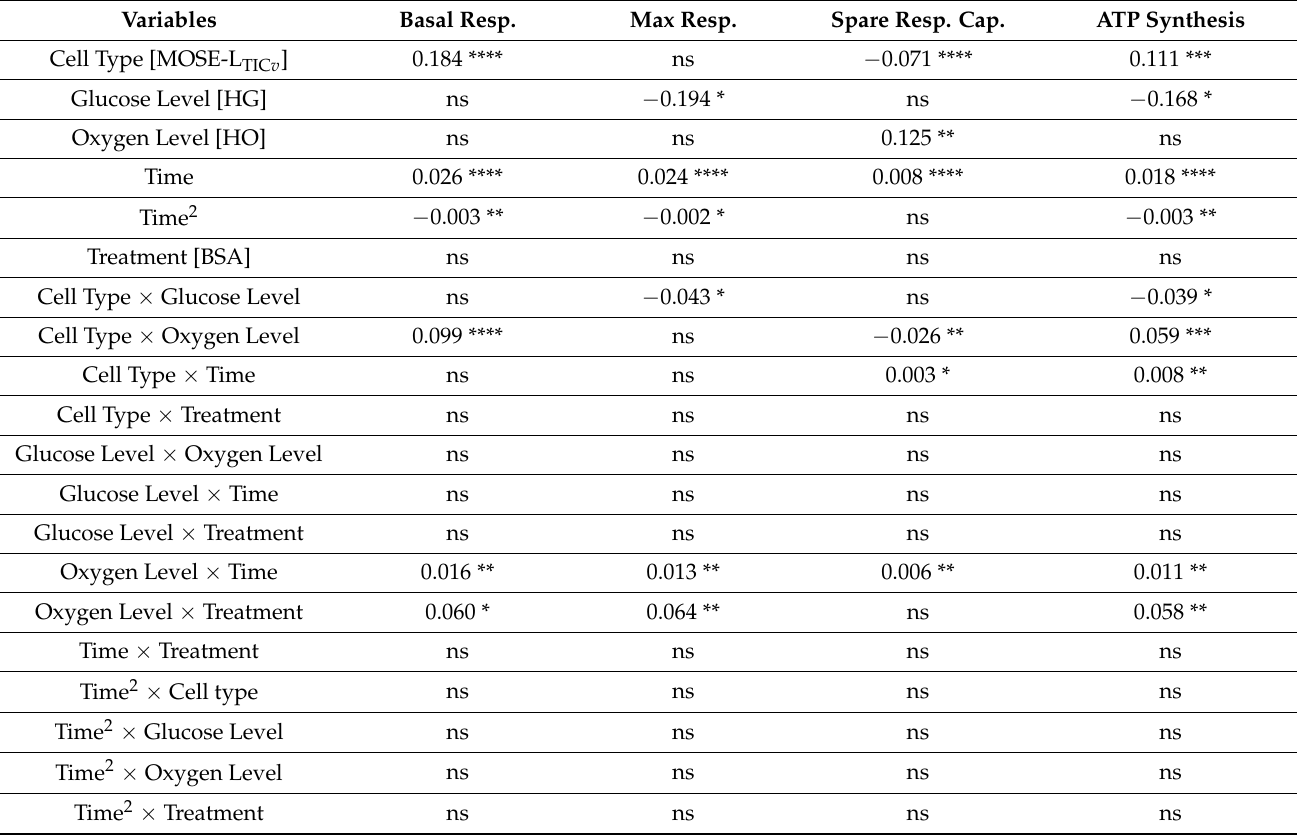
Table 1. Summary table of the fixed-effect models. * p < 0.05, ** p < 0.01, *** p < 0.001, **** p <